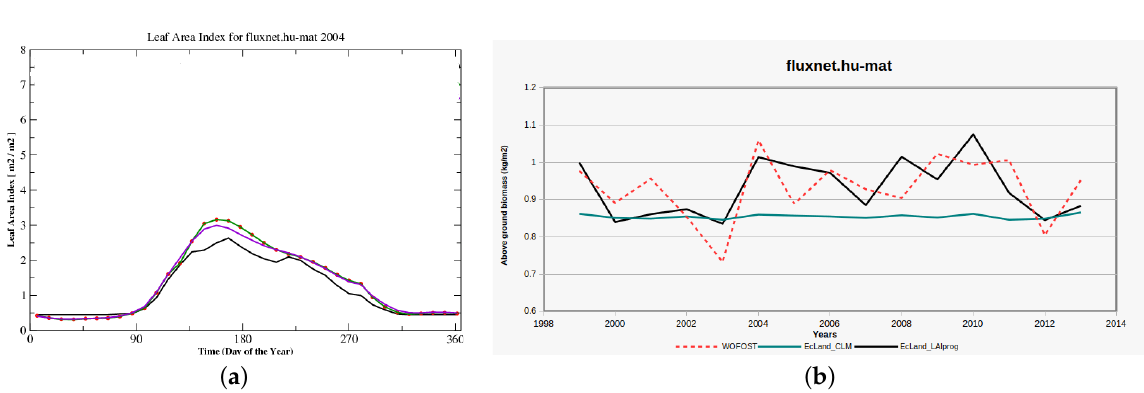
Figure 14. In-Situ evaluation of the vegetation related variables when using the growth model. ( a ) Observed LAI in m 2 /m 2 for 2004 at Fluxnet Hu-mat station (green with red dots), LAI climatology (purple), and prognostic LAI (black); ( b ) Above-ground biomass in kg/m 2 from WOFOST (red), ECLand with climatological LAI (green) and ECLand with prognostic LAI (black).